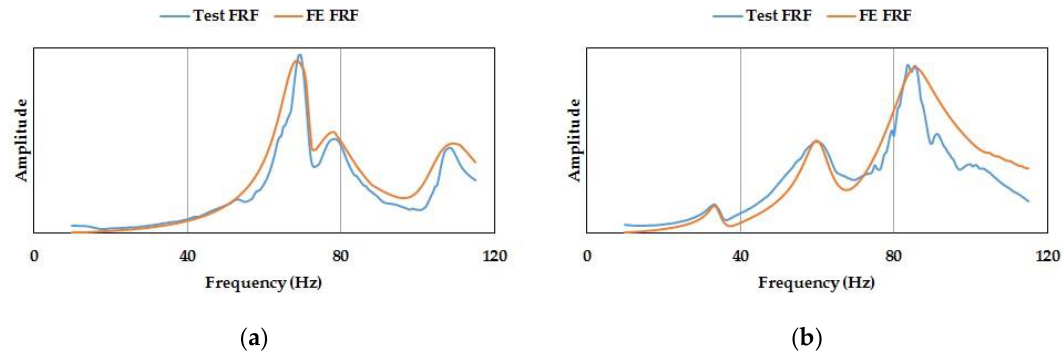
Figure 10. Test frequency response functions (FRFs) and synthetized FE FRF in point 5. ( a ) Response X, impact X; ( b ) response Y, impact Y.